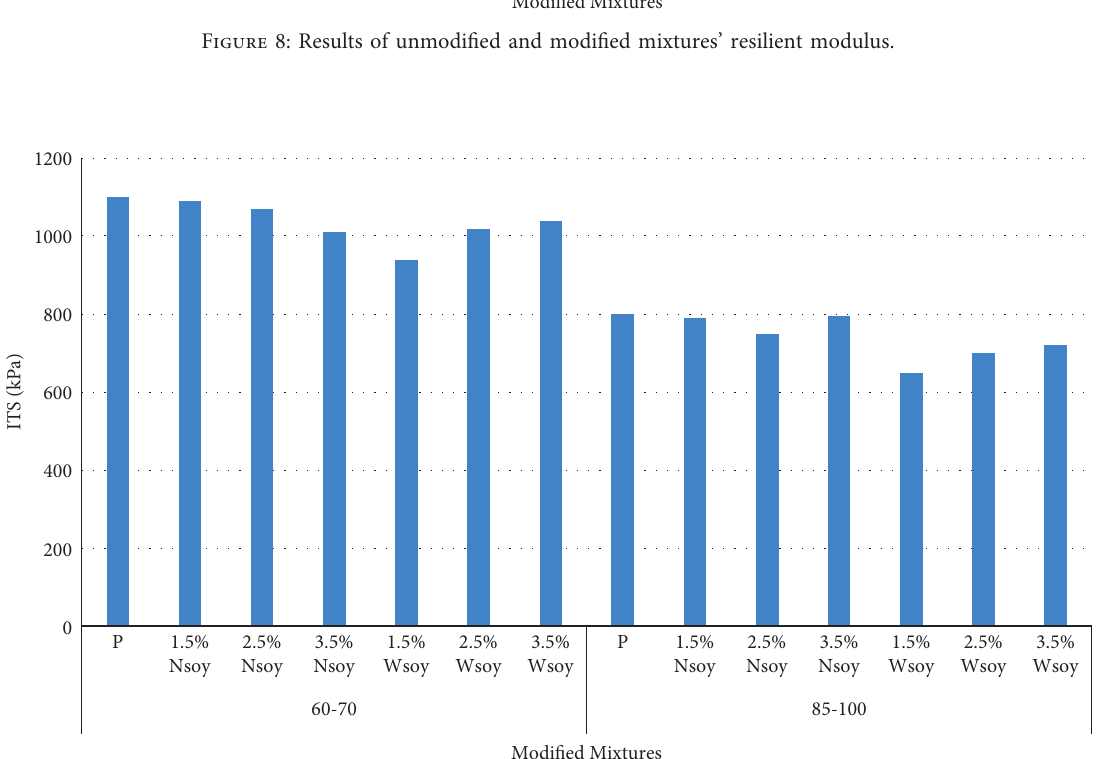
Figure 9: Unmodified and modified mixtures’ ITS